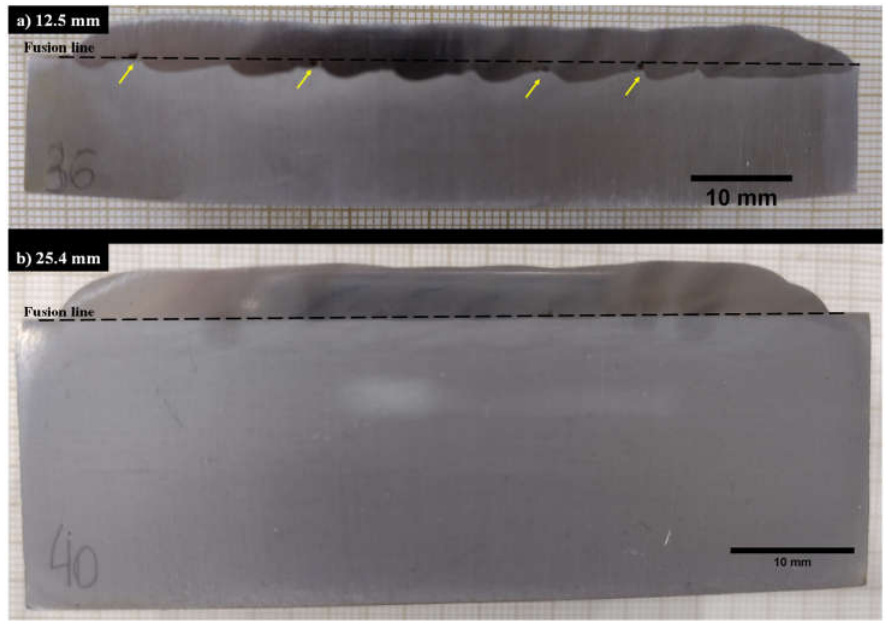
Figure 5. Cross section of the coatings deposited onto substrates with thicknesses of 12.5 mm ( a ) and 25.4 mm ( b ).